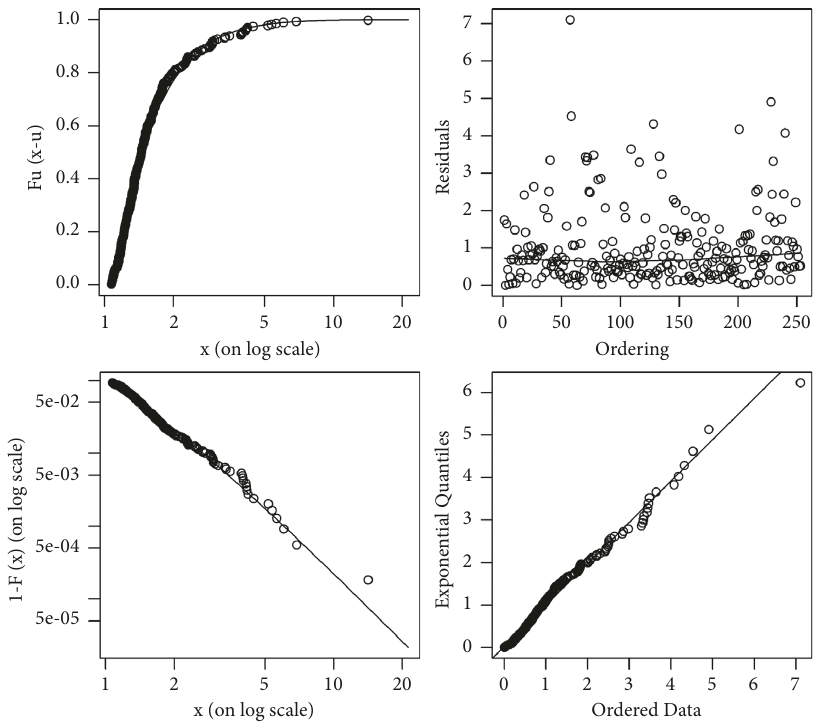
Figure 7: Rapeseed oil negative returns GPD fitted diagnostic plots.